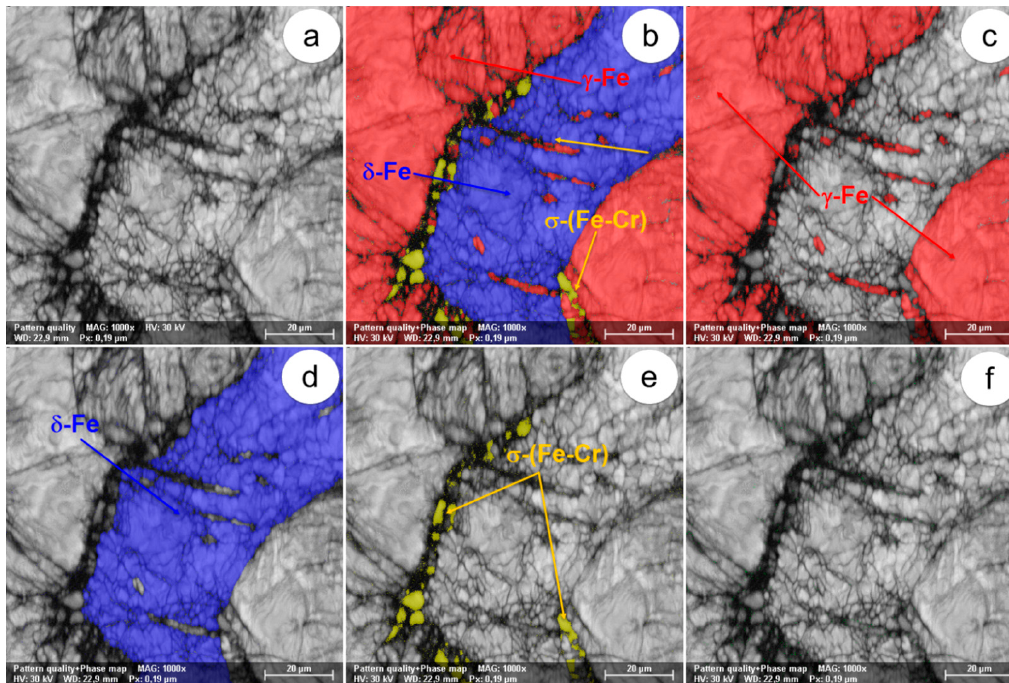
Figure 10. The SEM-EBSD composite images (×200) obtained after forging at 950 °C: ( a ) the microstructure of the analysed field; ( b ) the distribution of existing phases in the microstructure of the analysed field; ( c ) the distribution of the γ -Fe phase; ( d ) the distribution of the δ -Fe phase; ( e ) the distribution of the σ -(Fe-Cr) phase; ( f ) the distribution of the χ -(Fe-Cr-Mo) phase.